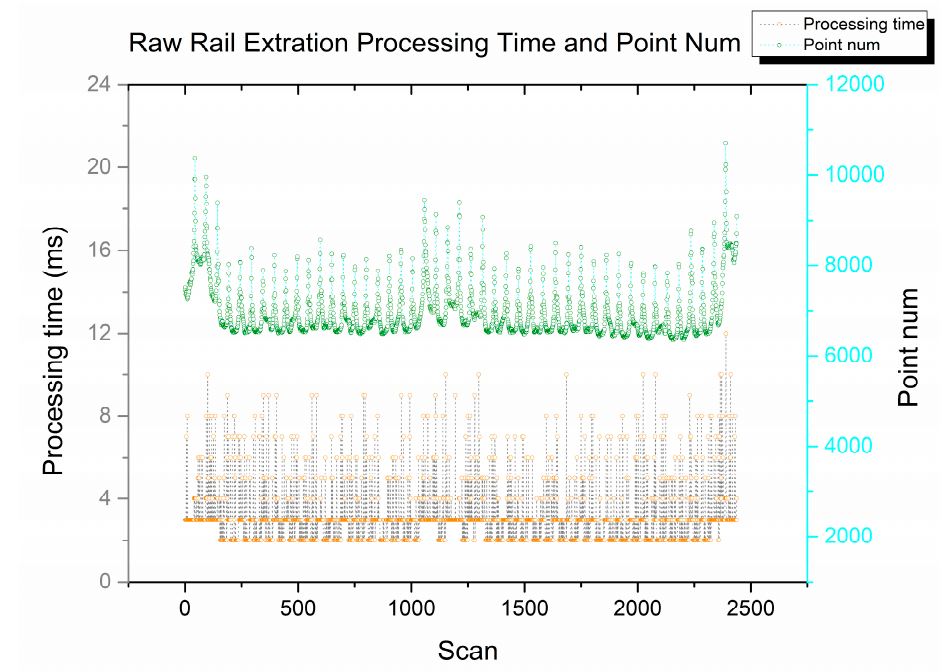
Figure 13. Timing of raw rail extraction step and point number of every scan.